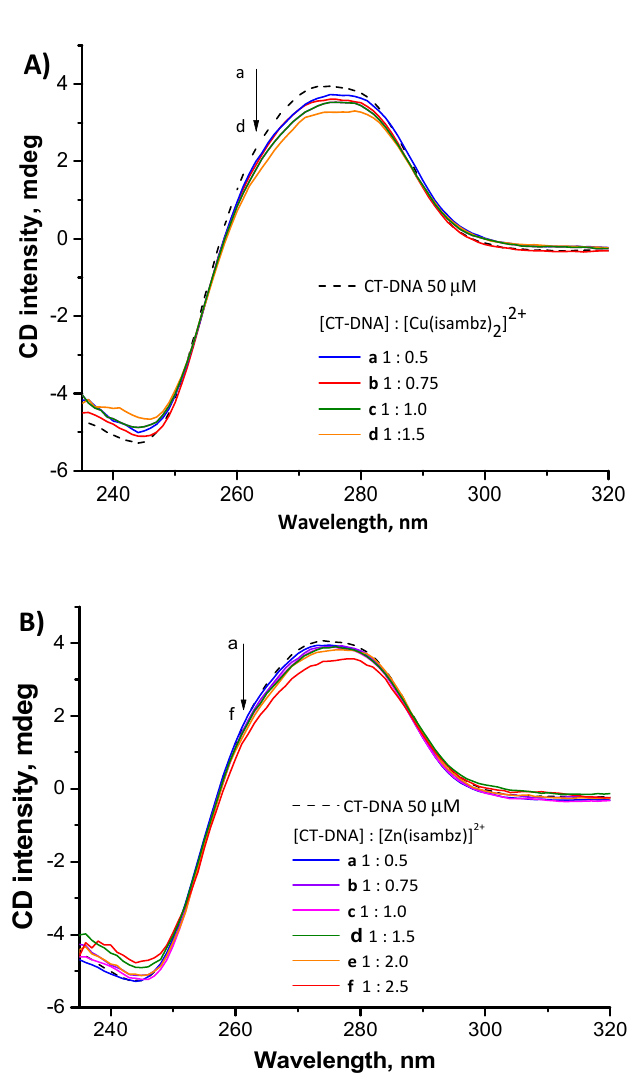
Figure 6. CD spectra of CT-DNA (50 µ M) in phosphate buffer 50 mM containing NaCl 100 mM, in the absence and presence of ( A ) varied concentrations of the copper(II) complex, [Cu(isambz)] 2+ 1 and ( B ) varied concentrations of the zinc complex [Zn(isambz)] 2+ 2